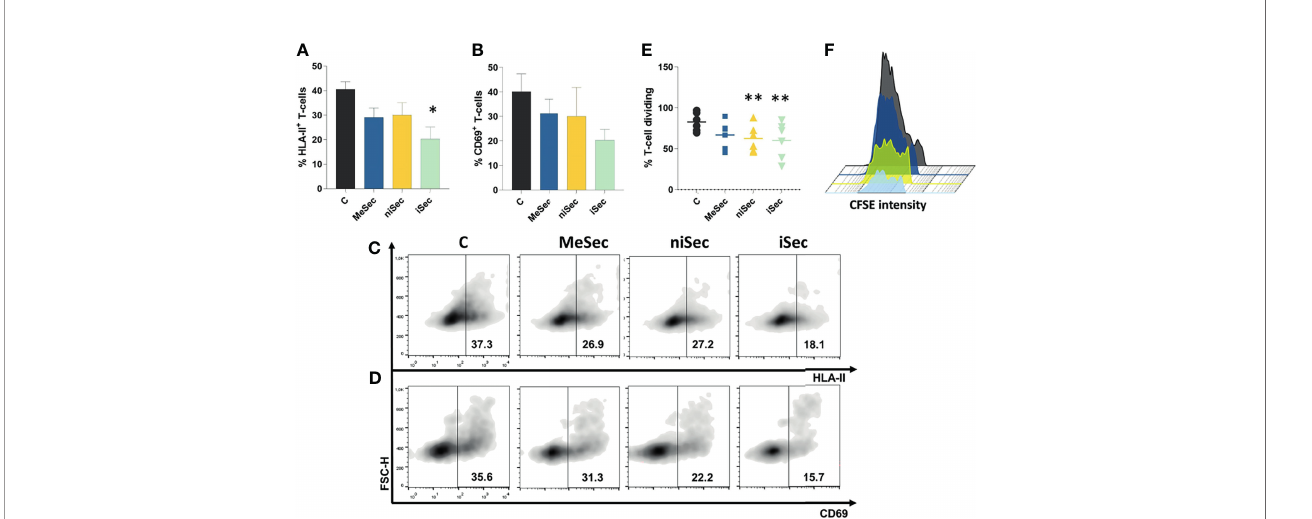
FIGURE 2 | iSec inhibits T-cell activation and proliferation. (A) HLA-II expression on T-cells after culture of PHA-activated PBMCs in RPMI (C) , MeSec, niSec, and iSec (B) CD69 expression on T-cells after culture of PHA-activated PBMCs in RPMI (C) , MeSec, niSec, and iSec. (C, D) Representative fl ow cytometric density plots showing expressions of HLA-II and CD69. (E) T-cell proliferation after culture of PHA-activated PBMCs in RPMI (C) , MeSec, niSec, and iSec. (F) Representative CFSE histograms of control group (black), PHA-activated PBMCs cultured in MeSec (dark blue), niSec (yellow), and iSec (light blue). Experiments were carried out with 3-6 PBMCs donors. Results are presented as mean ± SEM. *p < 0.05, **p < 0.01. Ten thousand events were recorded for each sample.